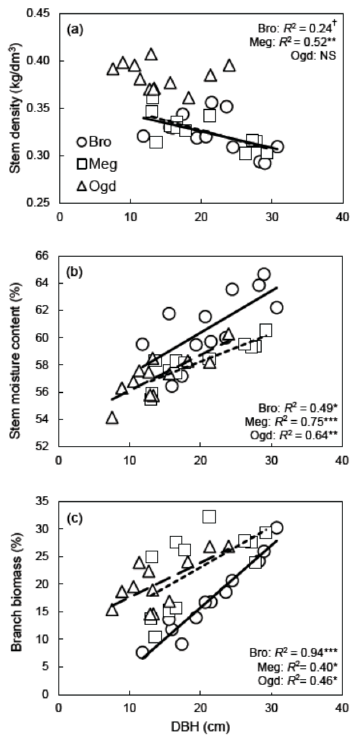
Figure 2. Site-specific linear least-square regressions between DBH and ( a ) stem wood basic density, ( b ) stem moisture content, and ( c ) the relative proportion of aboveground woody biomass consisting of branch biomass ( † p < 0.1, * p < 0.05, ** p < 0.01, *** p < 0.001). Brompton (Bro), solid line; Mégantic (Meg), small-dashed line; Ogden (Ogd), large-dashed line.